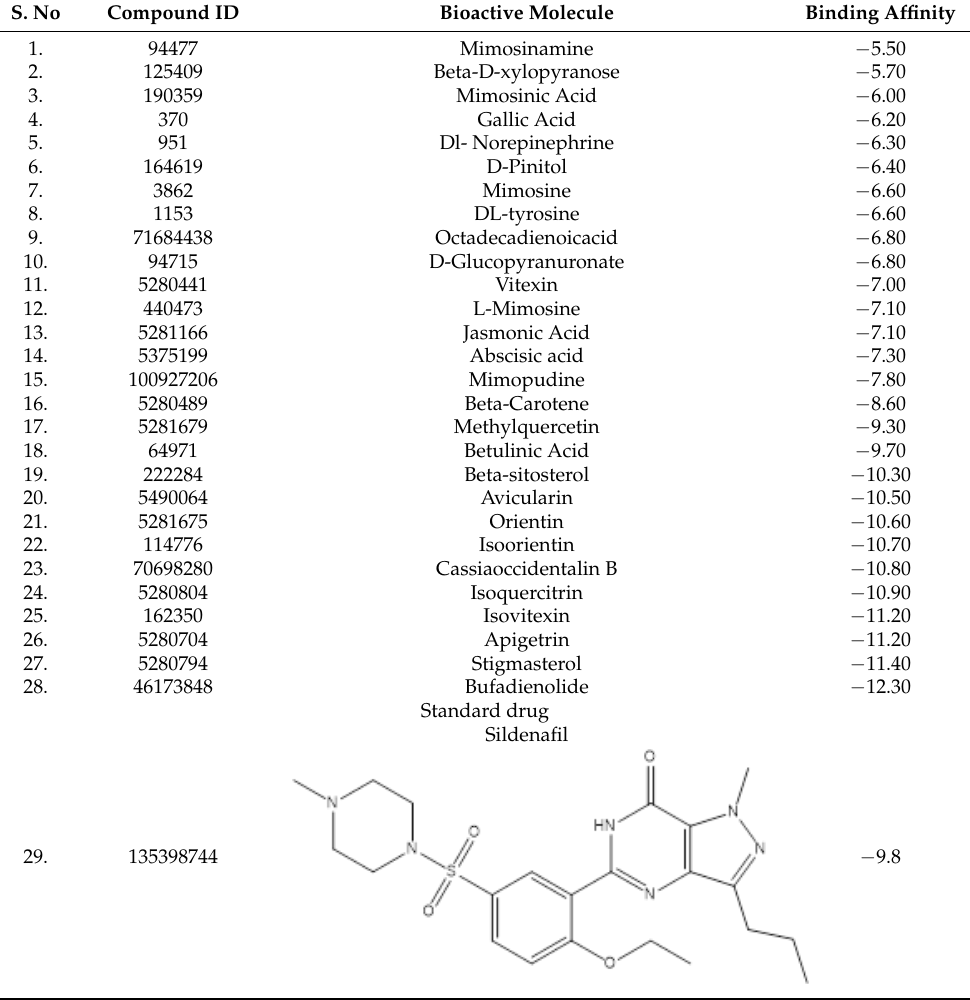
Table 2. Bioactive molecules from Mimosa pudica L. and their binding affinity against the phosphodi- esterase type 5 (PDE5) enzyme.